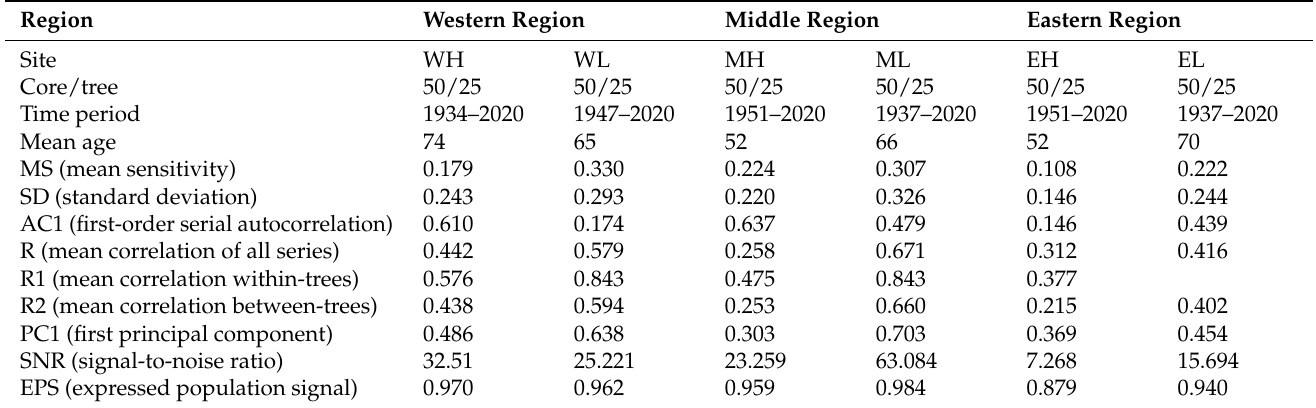
Table 2. Dendrochronological characteristics of chronologies for the Qinghai